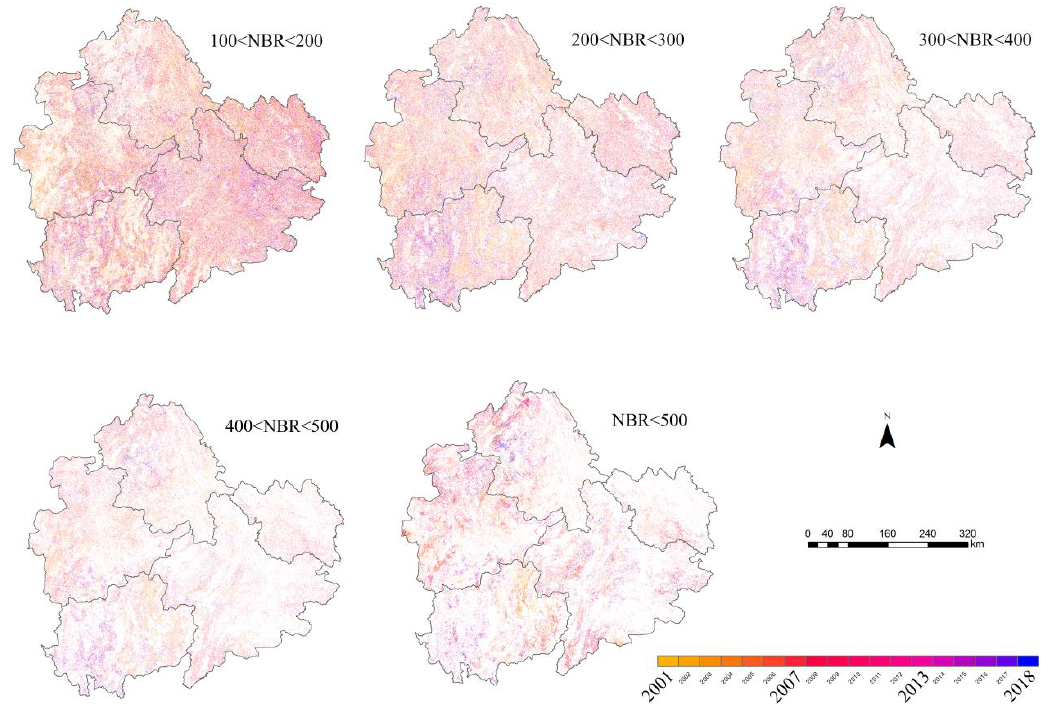
Figure 6. Temporal identification of land use volatility based on different change values of NBR.